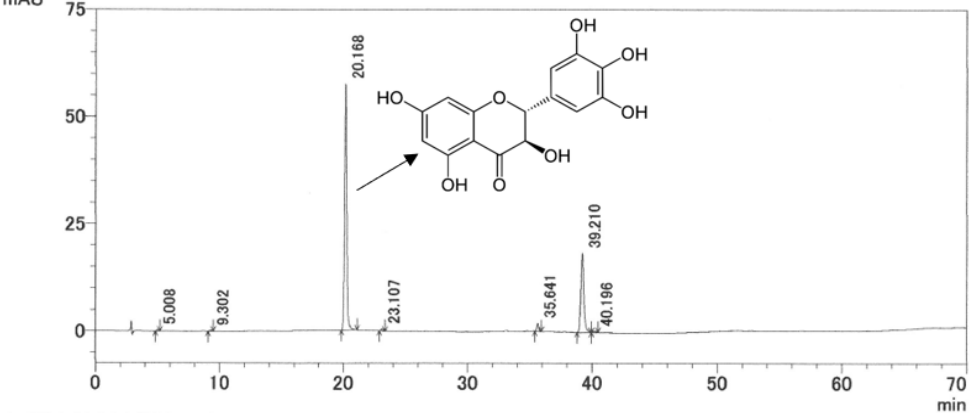
Figure 1. HPLC chromatogram of AG extract.